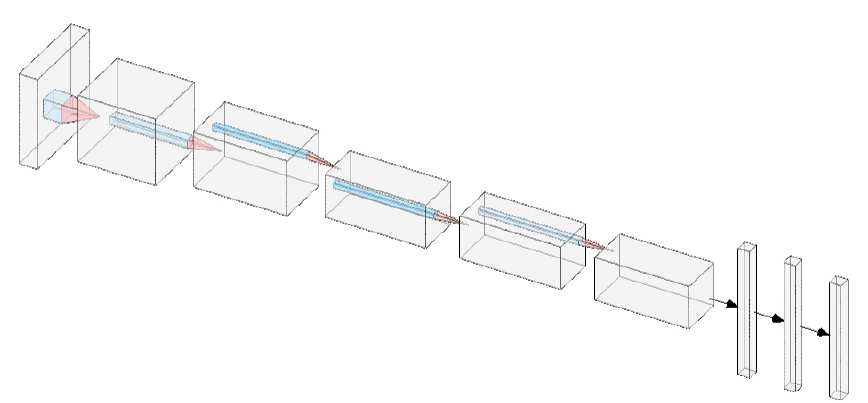
Figure 4. The architecture of the AlexNet deep CNN with six convolutional and three fully con- nected layers.